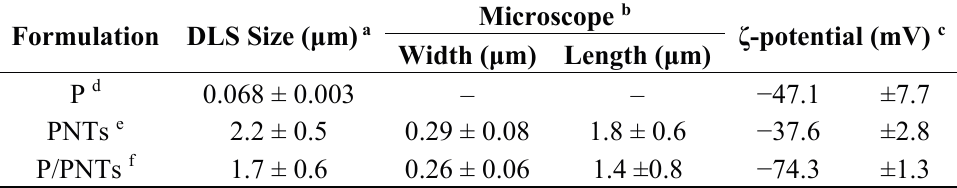
Table 1. Size and Zeta potential of CAP3 pRFP-C-RS (P) formulated with cyclo -( D -Trp-Tyr) peptide nanotubes (PNTs).